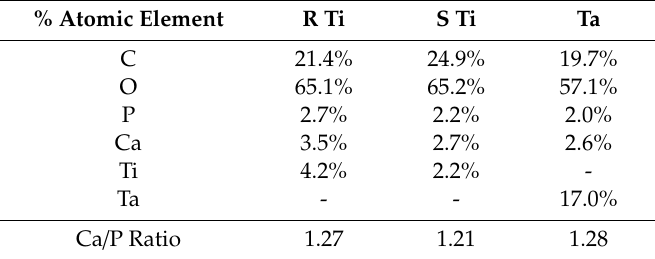
Table 2. Relative percentage (mean value) of atomic elements recovered by EDX spectroscopy. % Atomic Element R Ti S Ti Ta C 21.4% 24.9% 19.7% O